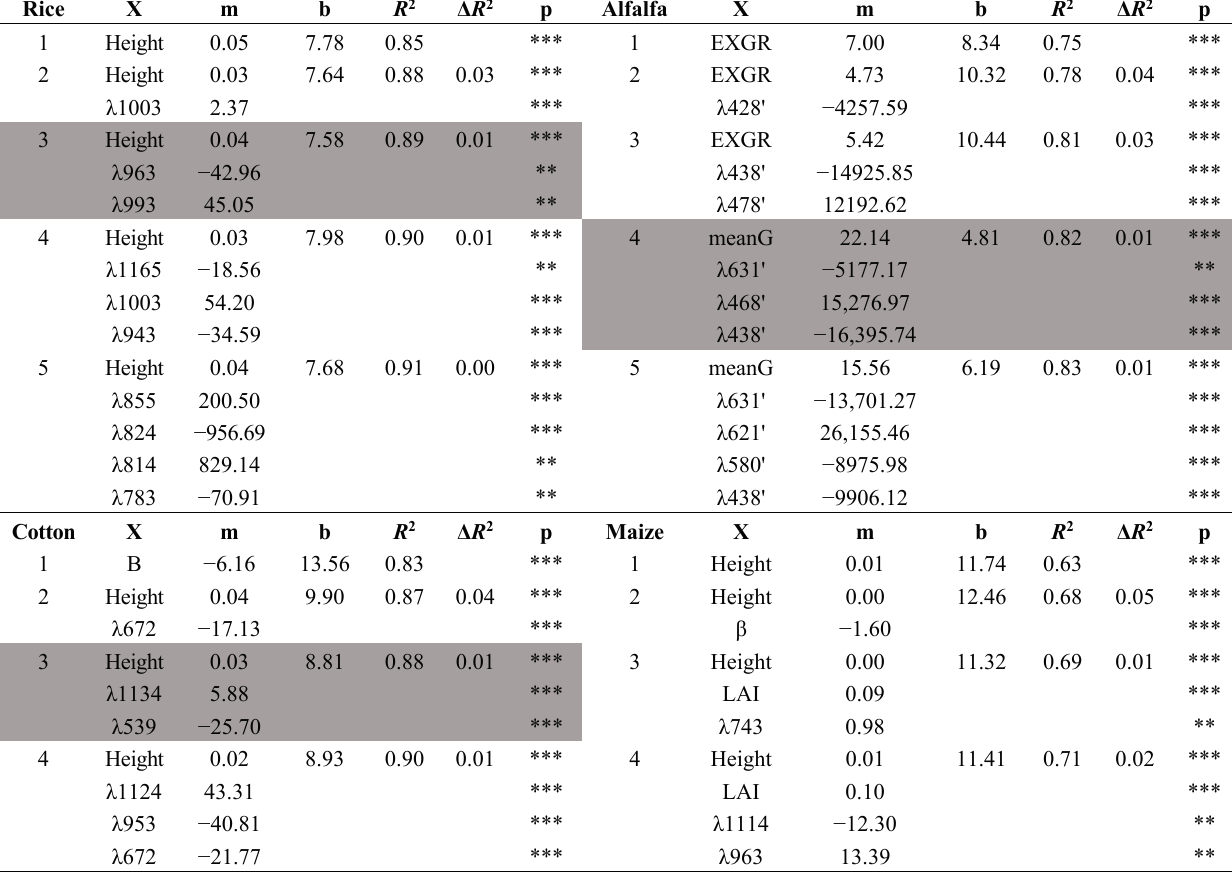
Table 2. The multiple-band vegetation index with the highest R 2 and lowest Bayesian Information Criterion at each step in the regsubset function. H is height (cm), LAI is the leaf area index (m 2 ·m − 2 ), β is the gap fraction, EXGR is the excess green minus excess red index, and meanG is the mean chromatic greenness. Hyperspectral narrowbands